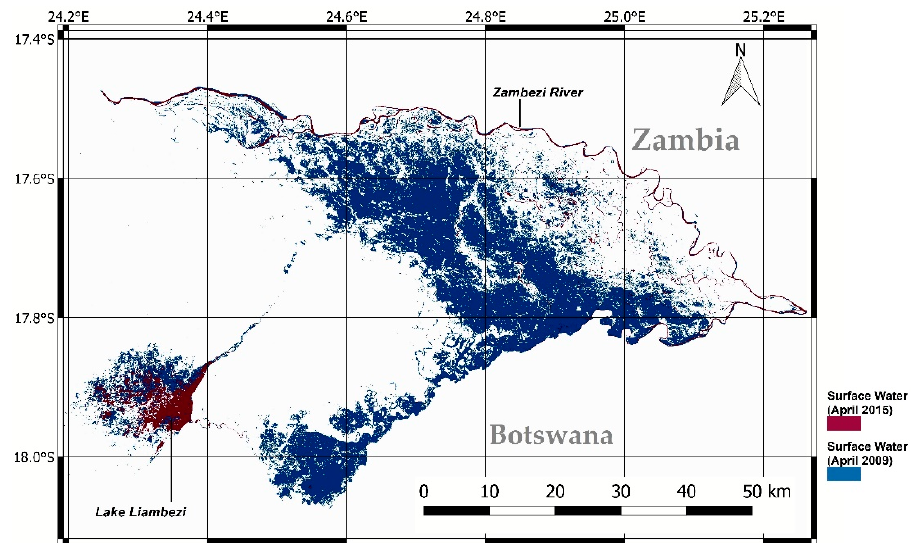
Figure 11. Comparison of surface water in April 2009 (blue) and April 2015 (purple) in the Zambezi Region.